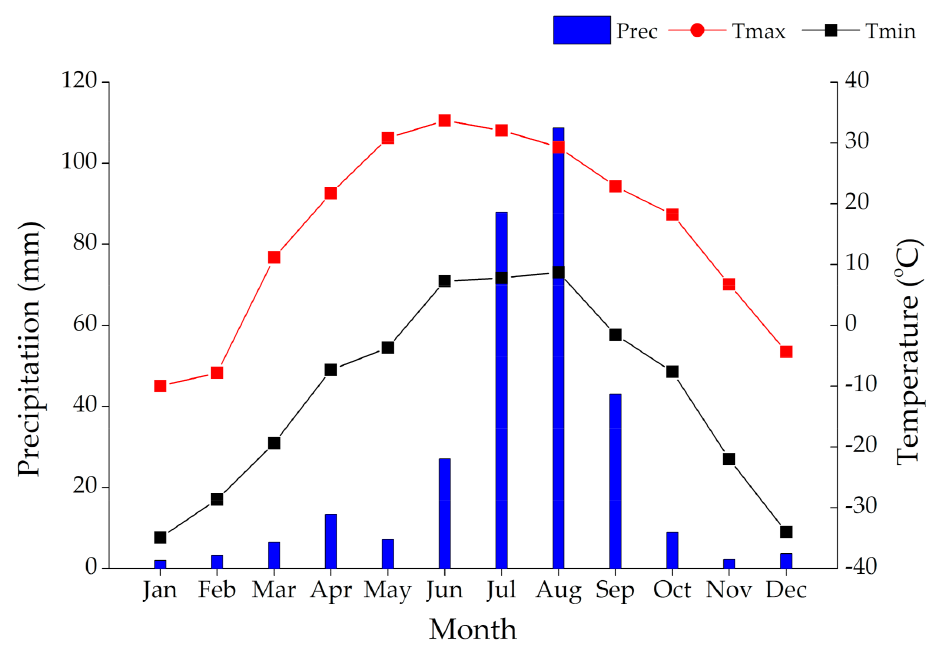
Figure 2. Annual variation of monthly maximum and minimum temperature, and monthly precipita- tion for 2018.